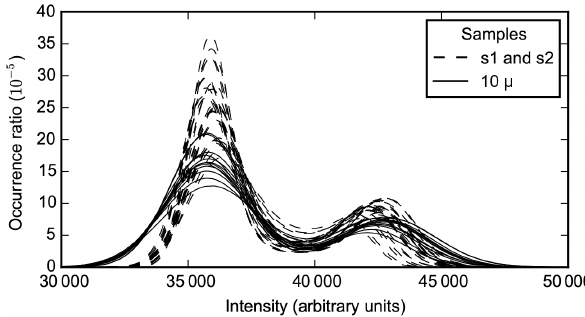
Figure 3. Grayscale distributions for all images. The solid lines and dashed lines respectively represent the distributions for the images scanned with the resolution 10 and 18µm. The greyscale distribu- tion is computed on 1000 bins of homogeneous size in the intensity range [30000, 50000] (arbitrary